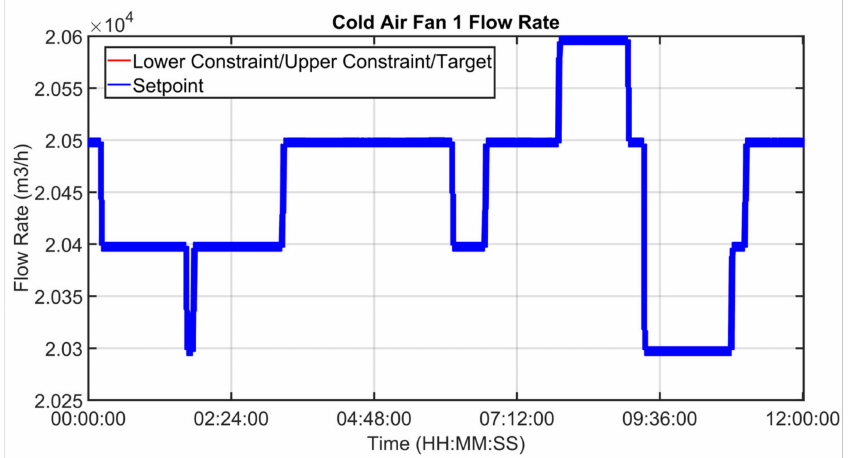
Figure 32. Grate cooler APC system: field results (cold air fan 1 flow rate MV).